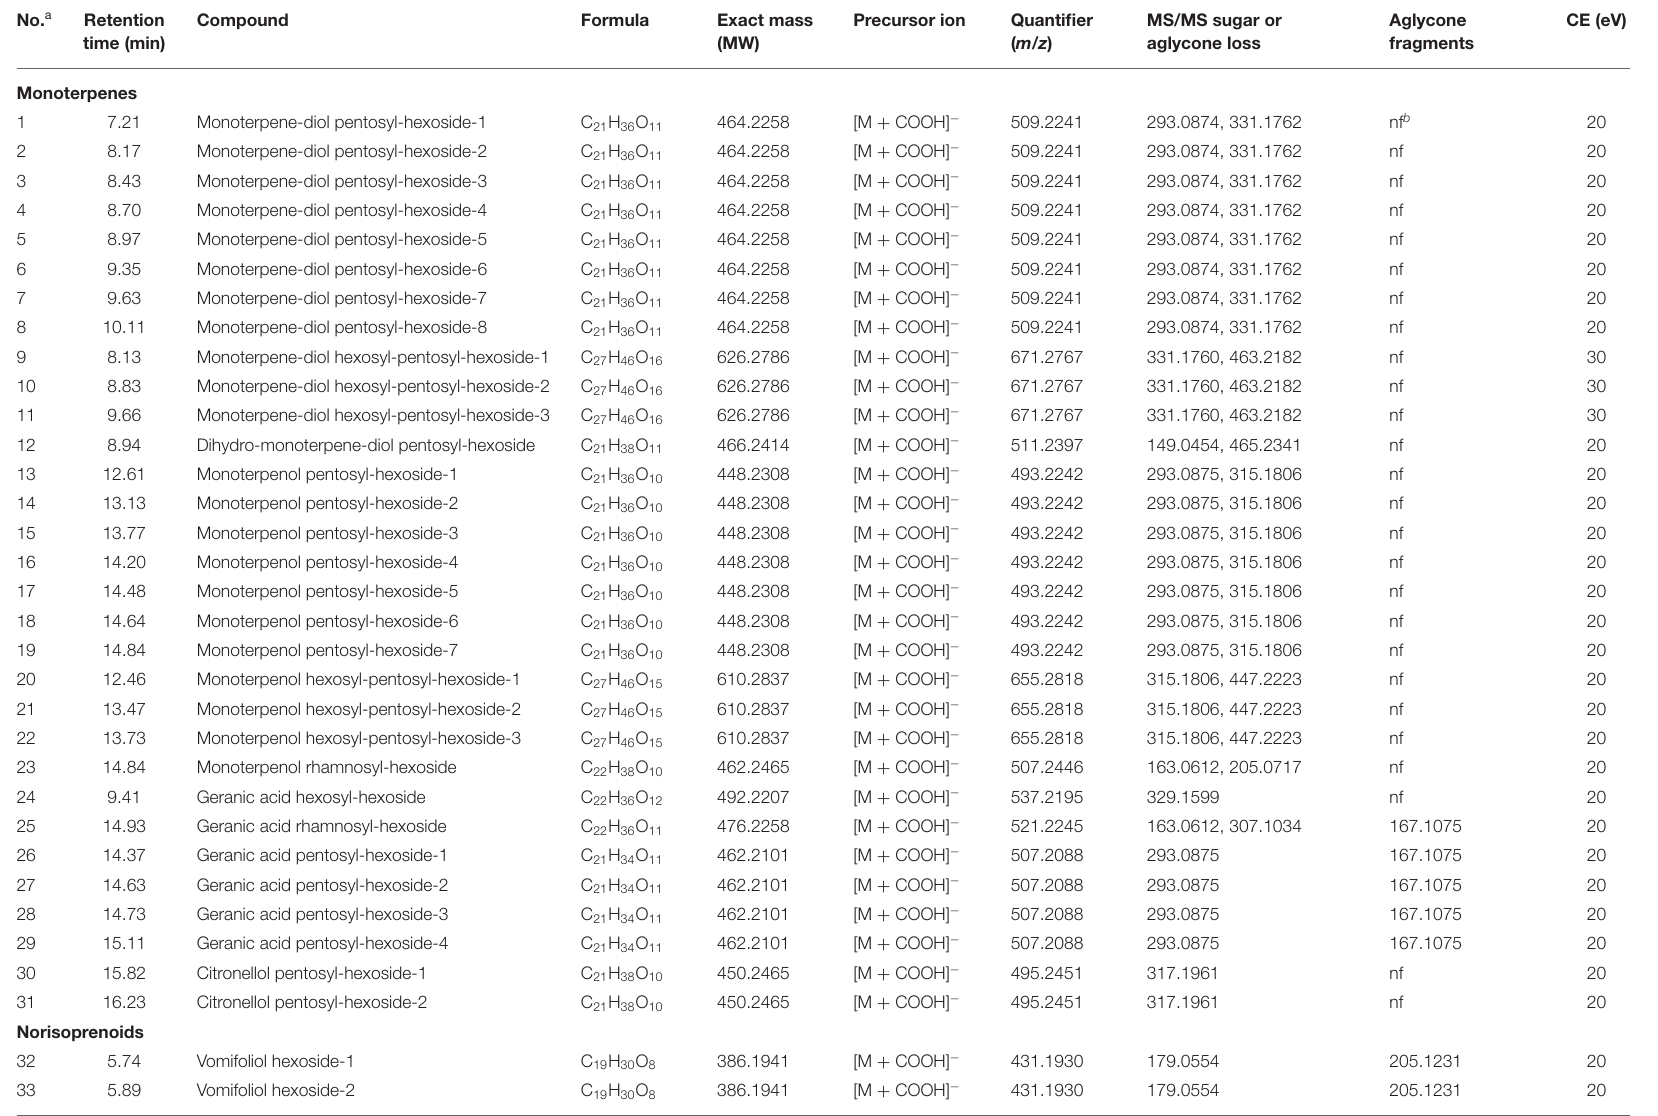
TABLE 1 | Primary mass spectrum information of glycosidic aroma compounds identified in 10 grape varieties. No.